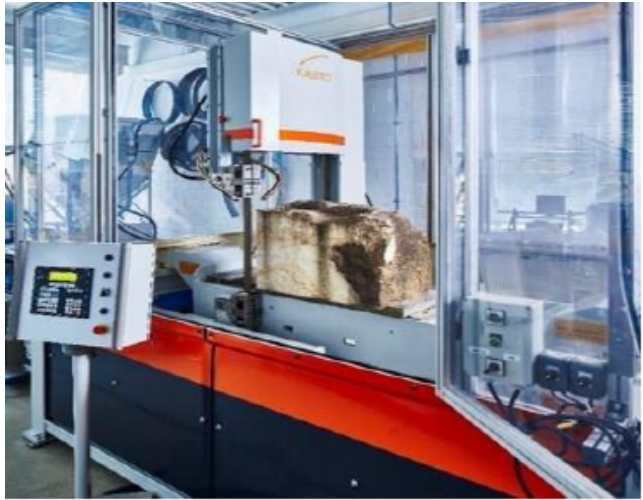
Figure 2. Kastoplate U3 bandsaw machine at TFF, Universität Kassel.